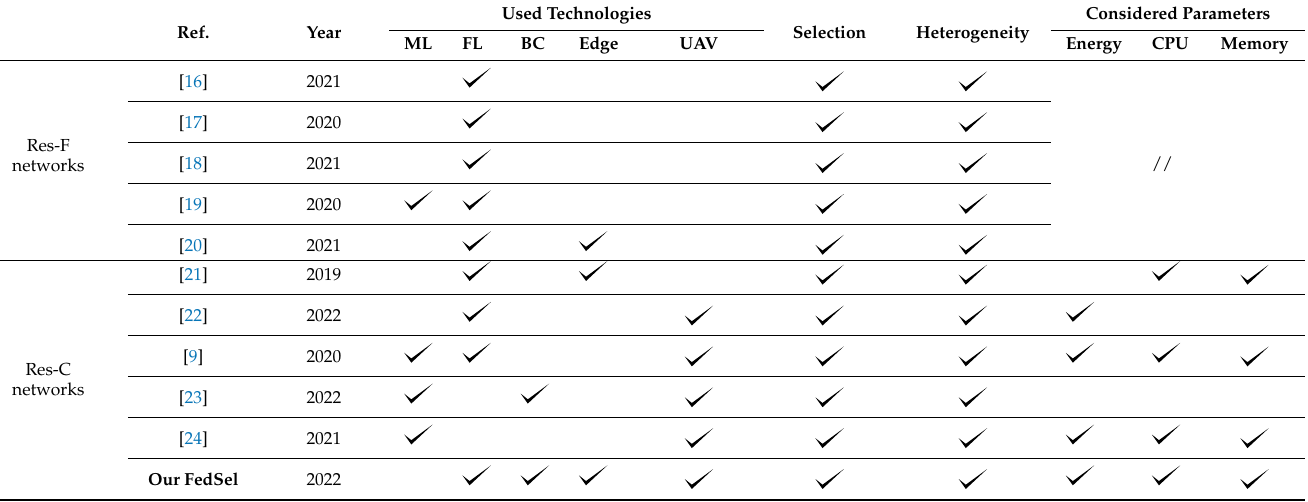
Table 2. A Comparative